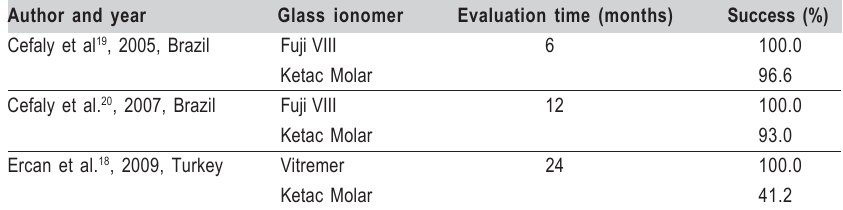
Table 3. Distribution of studies on longevity of multi-surface ART restorations